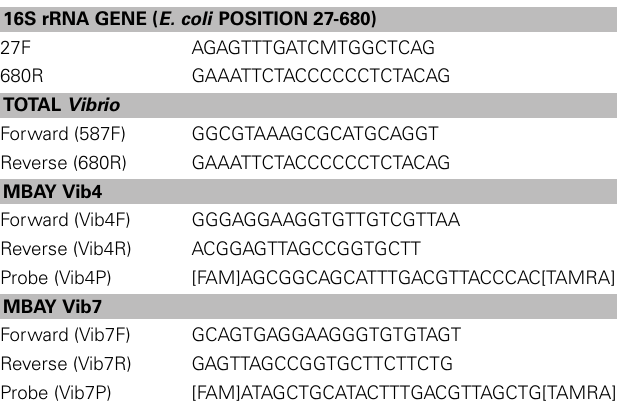
Table 1 | Primers and probes for PCR and qPCR (written 5 (cid:2) - > 3 (cid:2) ). 16S rRNA GENE ( E. coli POSITION